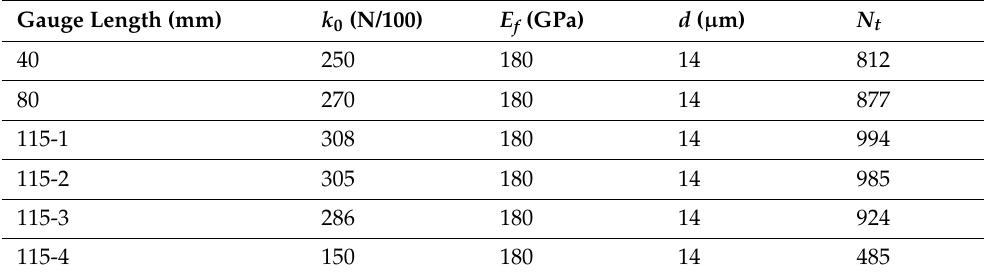
Table 1. Number of filaments carrying load initially, estimated from the slope of initial linear part of force–strain curves. Note that N t values are approximates that depend on the value of d . The important parameter is k 0 , which is commensurate with the number of fibers carrying load.